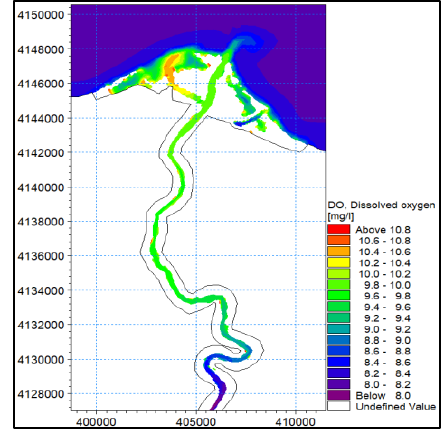
Fig. 2: The fish-bone model of anthropoid hazards causes and effects of Boujagh Wetland